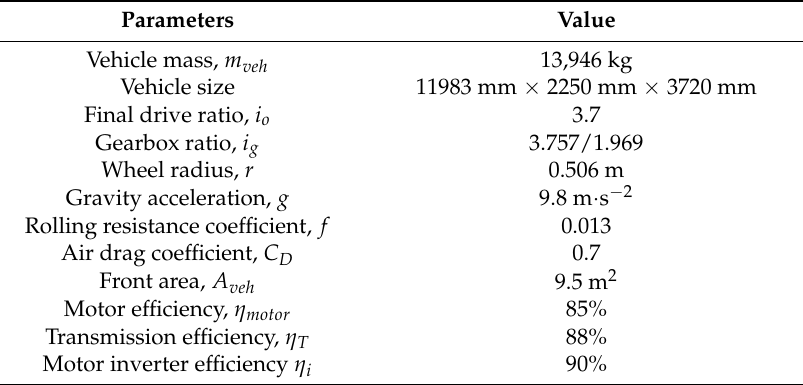
Figure 8. Components of vehicle operation cost. Table 2. Basic parameters of the electric bus.